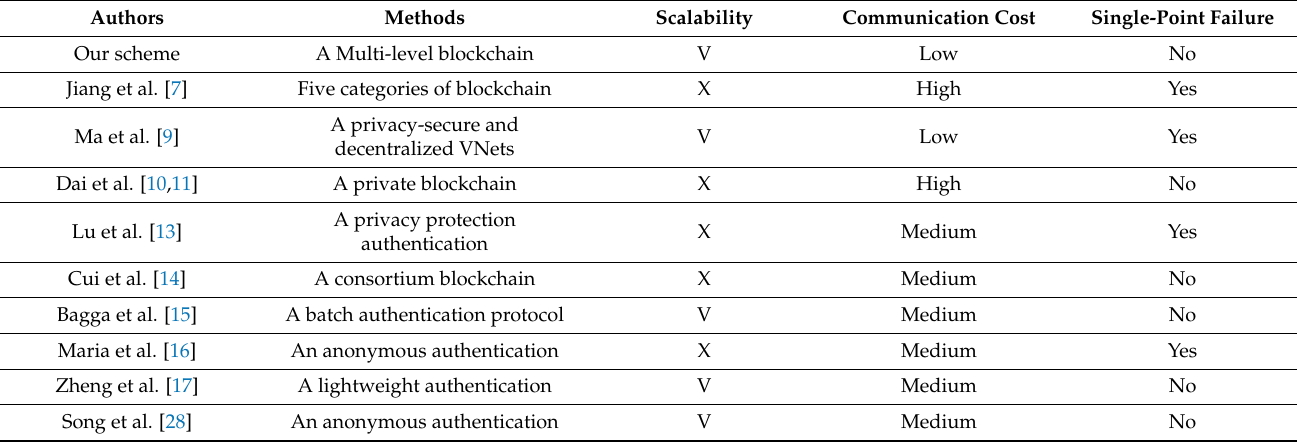
Table 2. The comparison of the related